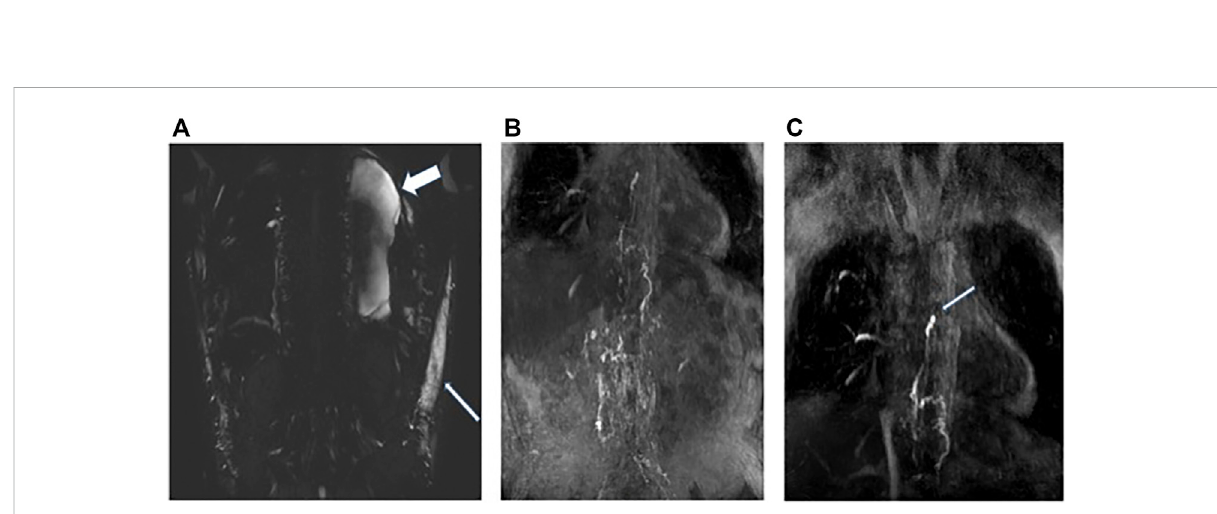
an increased accumulation of fl uid in the right pleural cavity and increasing skin and subcutaneous oedema of his abdomen, lower limbs and genitalia. A chest drain was inserted on the right and copious amounts of milky fl uid drained daily. At this point he was losing 6 L per day of chylous pleural fl uid, and it proved